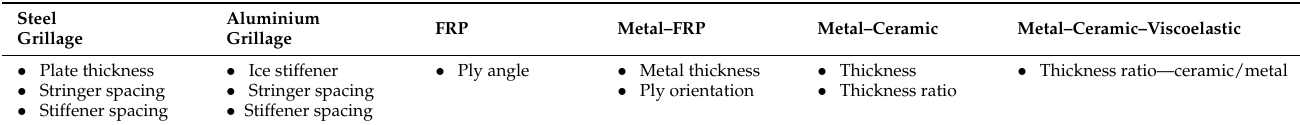
Table 8. Insignificant parameters for respective structural